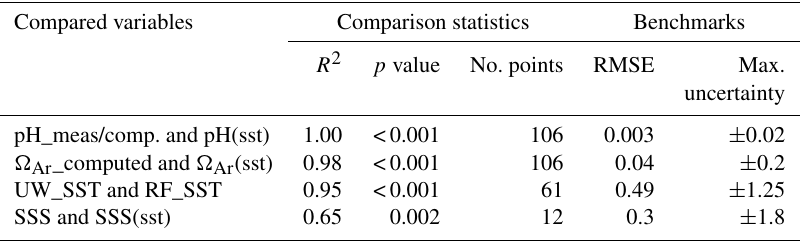
Table 3. Results of the comparisons between measurement-based and estimated values for pH, (cid:127) Ar , SST ( ◦ C), and SSS. For the first three parameters, the statistics of the linear relationships depicted in Fig. 2b–d are listed. For SSS, monthly averaged data are compared to estimates obtained with Eq. (1) using monthly SST. For SST, the comparison is carried out to verify that measurements from Raunefjord are representative for the whole study area (i.e. UW_SST can be estimated by RF_SST), which is implicitly assumed by the use of Eq. (1). R 2 is the coefficient of determination, and “RMSE” denotes the root-mean-square error. The latter is compared against benchmarks derived from maximum target uncertainties (max. uncertainty) developed by Global Ocean Acidification Observing Network (Sect. 3.1). The p value is the probability of no linear relation between the estimated and measurement-based